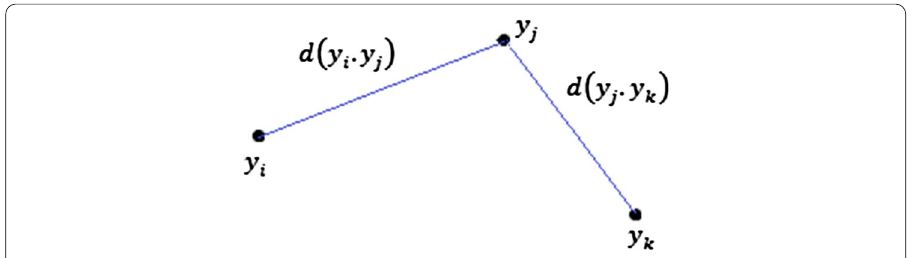
Fig. 1 The LLE neighborhood